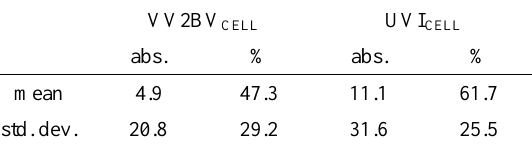
Table 1. Mean and standard deviation values for VV2BV and UVI indices in ‘cell’ variant. Cell size equal to 100m.